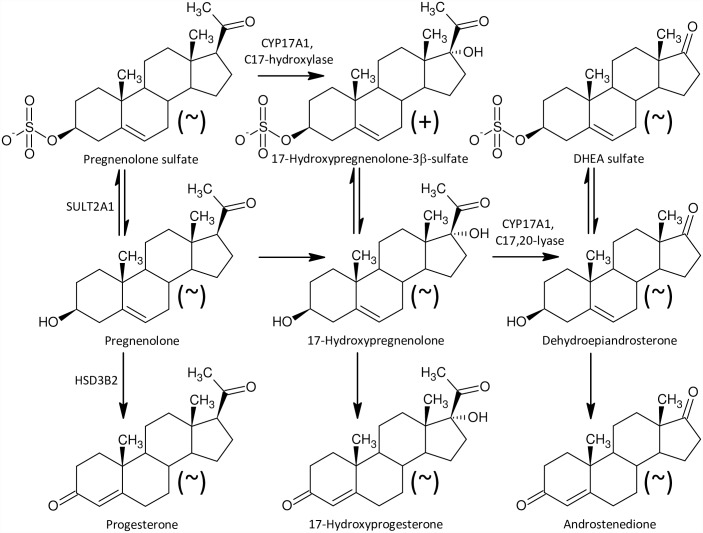
A simplified scheme of steroidogenesis in the Δ5 and Δ4 metabolic pathways in humans.The symbols in parentheses “+” and “~” represent increased and unchanged steroid levels, respectively, in the ICP group.